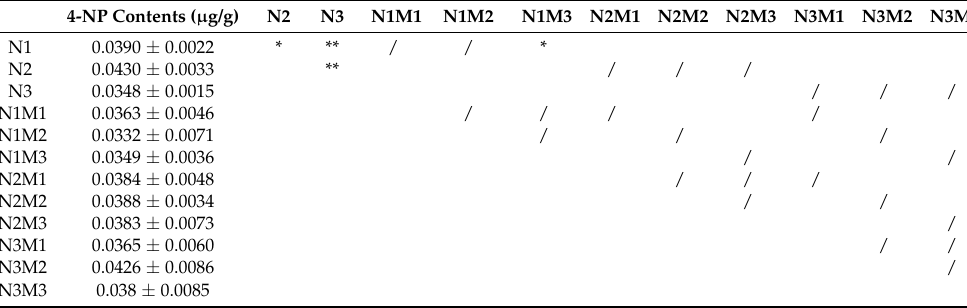
Table 8. Statistical analysis of 4-NP contents in muscle at Day 30.